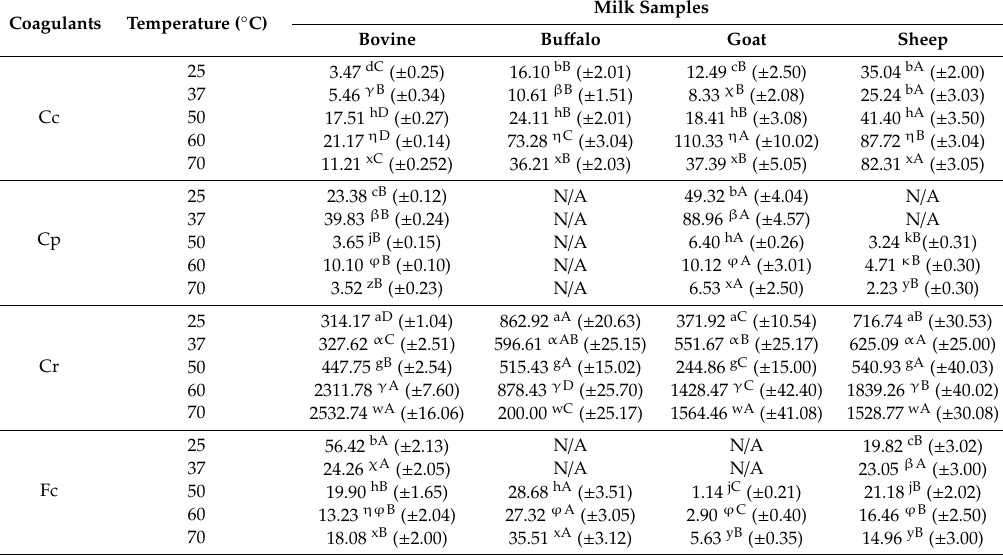
Table 2. Milk clotting indexes (MCIs) obtained for C. cardunculus exctract (Cc), C. papaya (Cp), Calf rennet (Cr) and F. carica (Fc) latexes, in bovine, bu ff alo, goat and sheep milks, at di ff erent incubation temperatures (25, 37, 50, 60 and 70 ◦